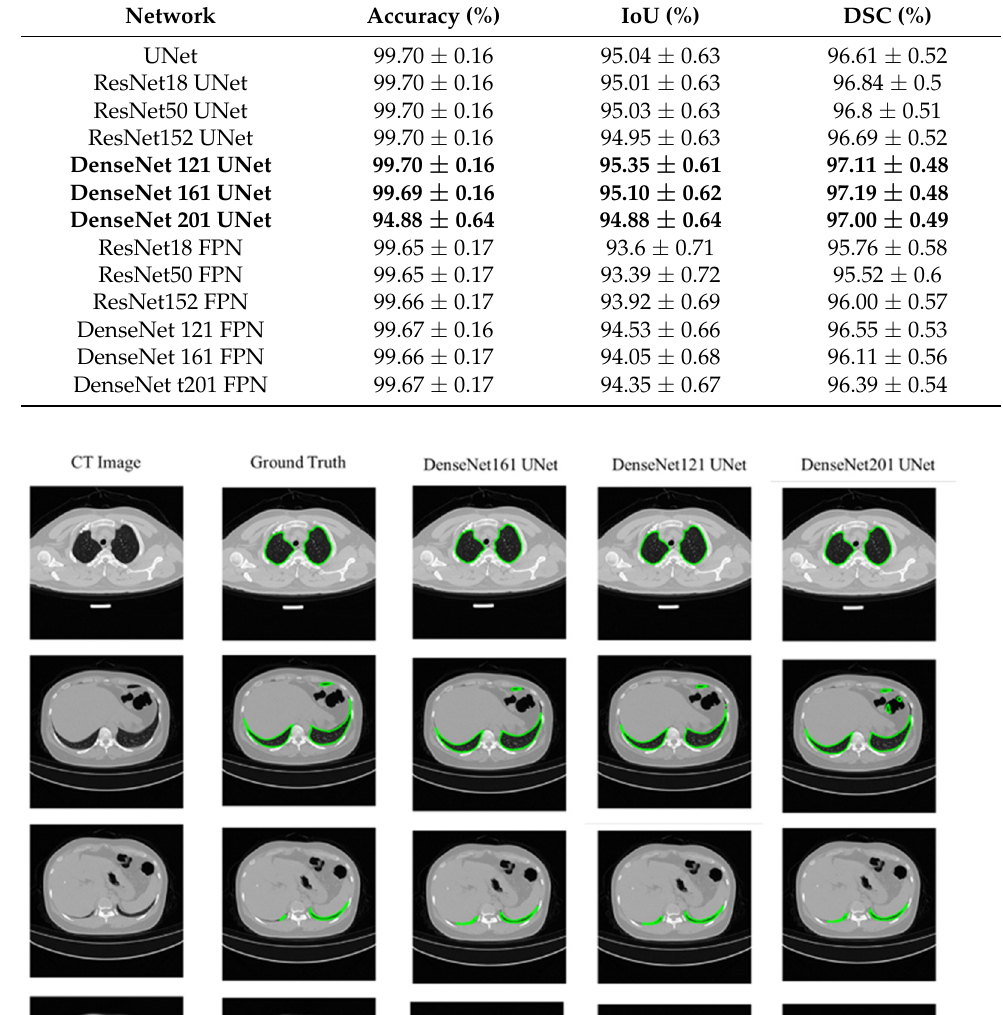
Table 5. Results of 5-fold cross-validation of Lung segmentation (Best results are formatted in Bold).